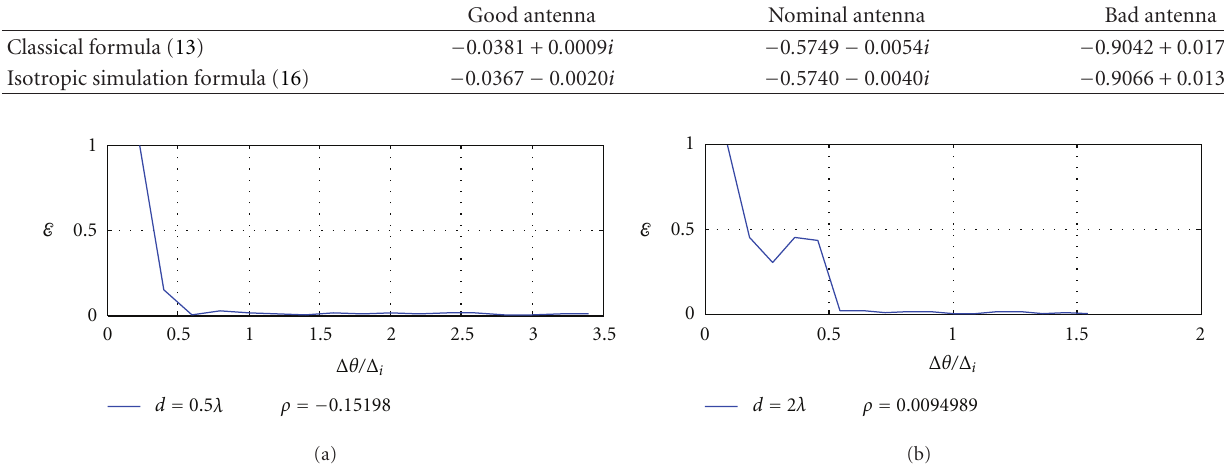
Table 1: Correlations computed from the classical formula (13) and from the isotropic simulation formula (16) with 180 plane-wave directions of propagation. The data is collected at 751 MHz.